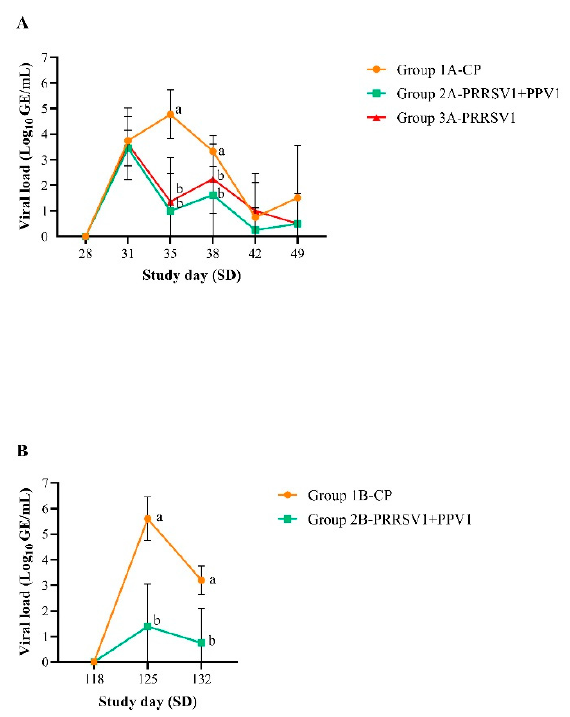
Figure 2. PRRSV viral RNA load (mean ± standard deviation) in gilts from challenge onwards in experiments A ( A ) and B ( B ). PRRS viral RNA load was assessed in sera using RT-qPCR. Generated data in log10 GE / mL were used for comparisons of mean values between groups using the Wilcoxon Mann–Whitney test. For statistical purposes, a RT-qPCR result of “not detected” was assigned a value of 0.0 log10 GE / mL, while a result of “positive” but unquantifiable was assigned a value of 3.0 log10 GE / mL. Di ff erent letters indicate statistical significance of di ff erences between groups.